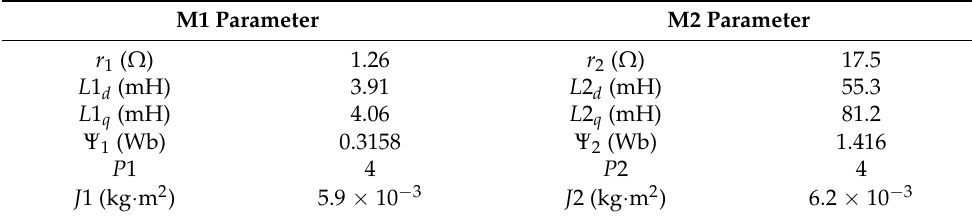
Figure 16. The experimental platform of dual − series FPMSM. The parameters of the two motors are shown in Table 1. Motor 1 is a sinusoidal five − phase motor with 6% of the harmonic back EMF and motor 2 (THI − FPMSM) contains 24.3% of the third harmonic flux − linkage. Table 1. Motor parameters. Table 1. Motor parameters.